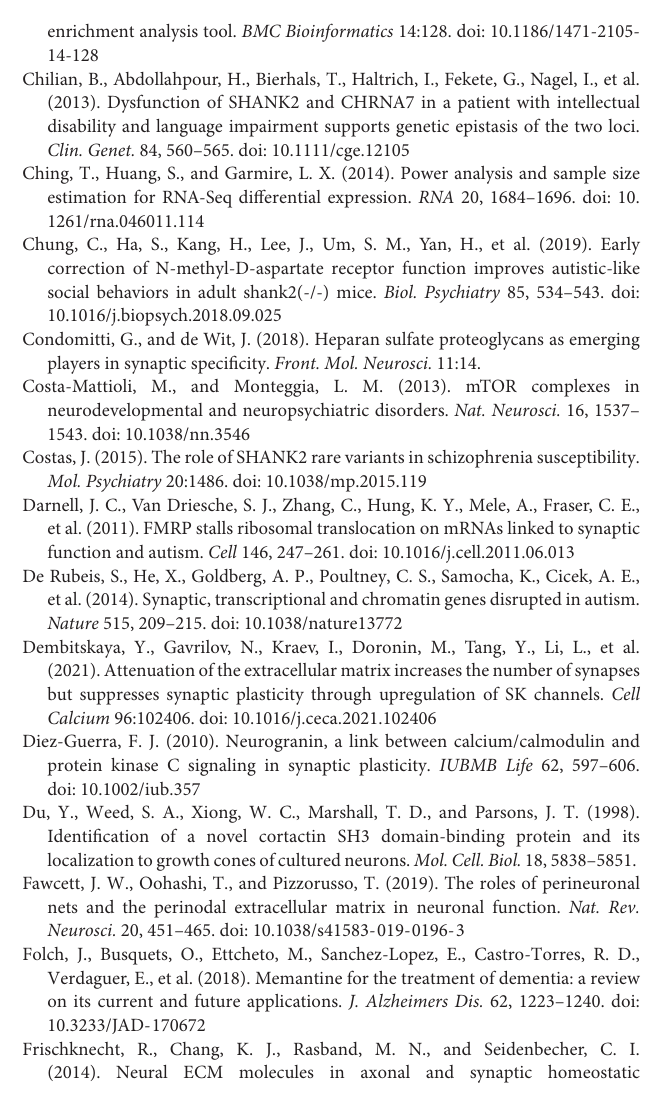
Supplementary Table 4 | Gene Set Enrichment Analysis results (C5-CC, C5-BP, and C5-MF) for Veh-K/W and Mem-K/W transcripts. Supplementary Table 5 | Gene Set Enrichment Analysis results (C5-CC, C5-BP, and C5-MF) for KO-M/V and KO-M/WT-V transcripts. Supplementary Table 6 | Gene Set Enrichment Analysis results (C5-CC, C5-BP, and C5-MF) for WT-M/V and WT-M/KO-V transcripts. Supplementary Table 7 | Details on the top enriched gene sets in Veh-K/W, Mem-KO/WT, and KO-M/V transcript groups, showing information on individual genes contributed to the enrichments such as original rank and running enrichment score. The rank metric score for each gene in GSEA is calculated by using a default signal-to-noise ratio ranking metric. The rank of 14 for HTR2A indicates its rank in the whole-gene input list. A tap also indicates the association of the genes that significantly contributed to the enrichment of Veh-K/W transcripts for “postsynaptic membrane” gene sets with excitatory, inhibitory, and both excitatory and inhibitory synaptic functions. Supplementary Table 8 | List ASD-related/risk and cell-type-specific gene sets used for